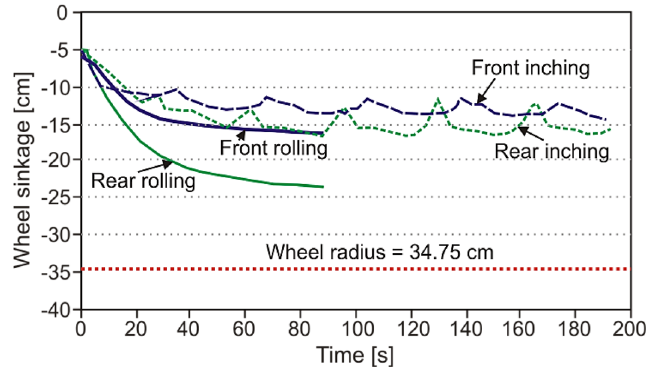
Figure 4. Wheel sinkage of the Scarab NASA rover in DIC measurements 32 .